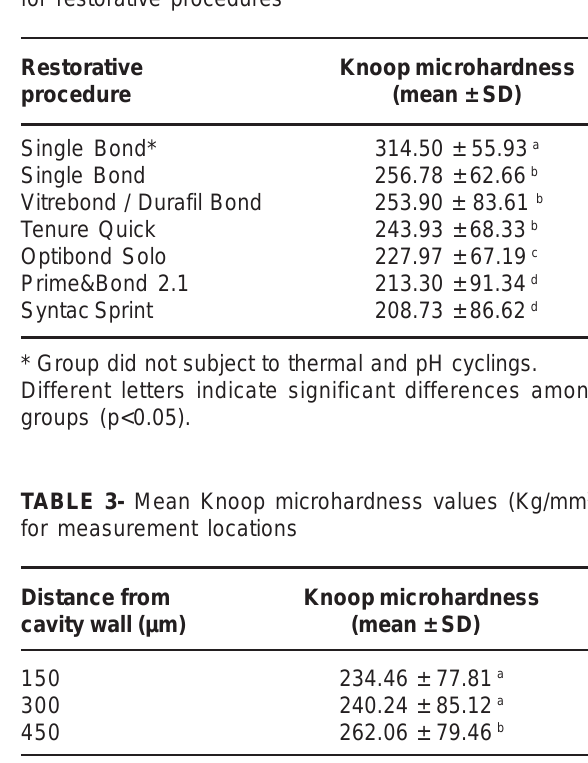
TABLE 2- Mean Knoop microhardness values (Kg/mm 2 ) for restorative procedures